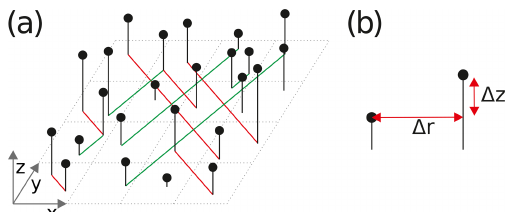
Figure 3. Height and distance relations of points in the point cloud used to calculate the height–height correlation function. (a) Ar- rangement of points above a fitted mean plane: dashed grid showing mean plane, black lines symbolizing orthogonal distance between plane and points, and red/green lines showing relative orientation between points. (b) Distance ( (cid:49)r ) and height difference ( (cid:49)z ) be- tween